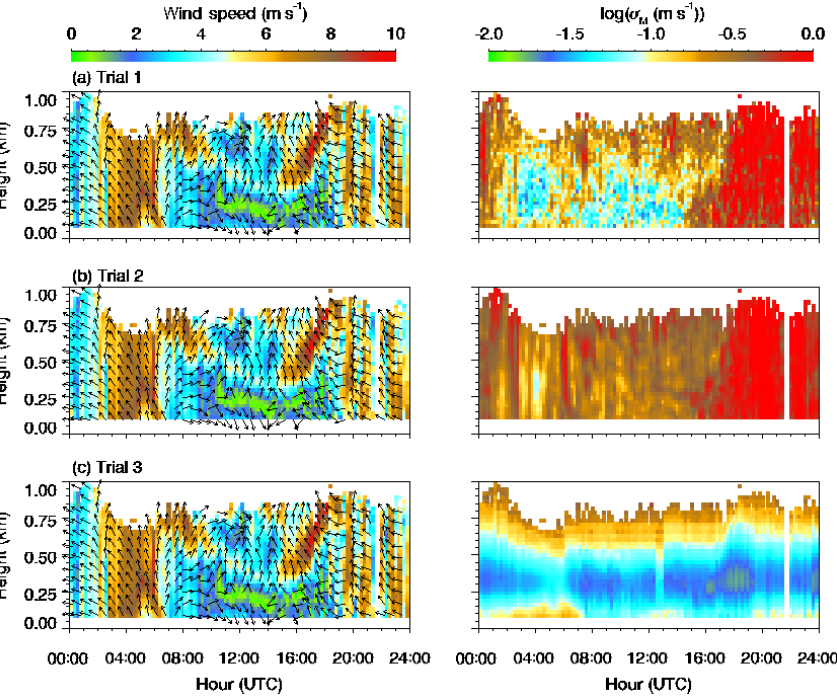
Figure 4. Time–height plots of the retrieved wind speed (left) and estimated wind speed precision (right) for 4 April 2015 for (a) Trial 1, (b) Trial 2 and (c) Trial